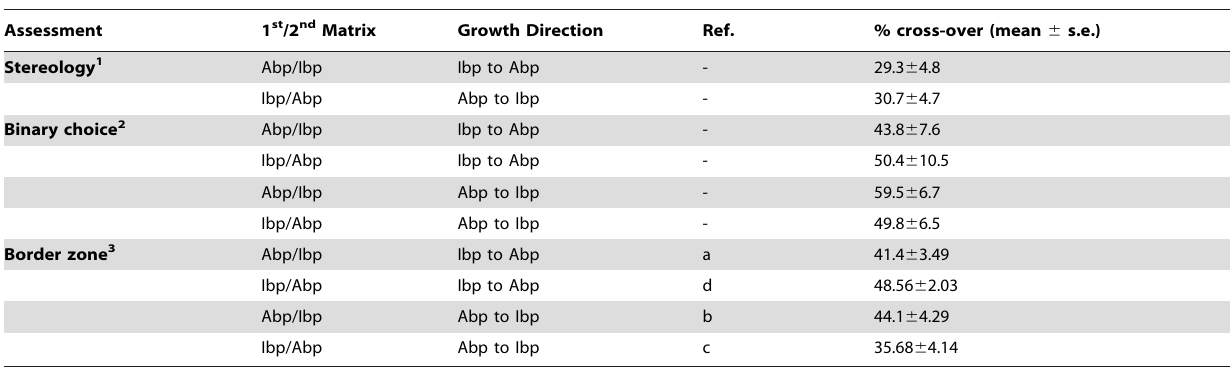
Table 6. Abp versus Ibp